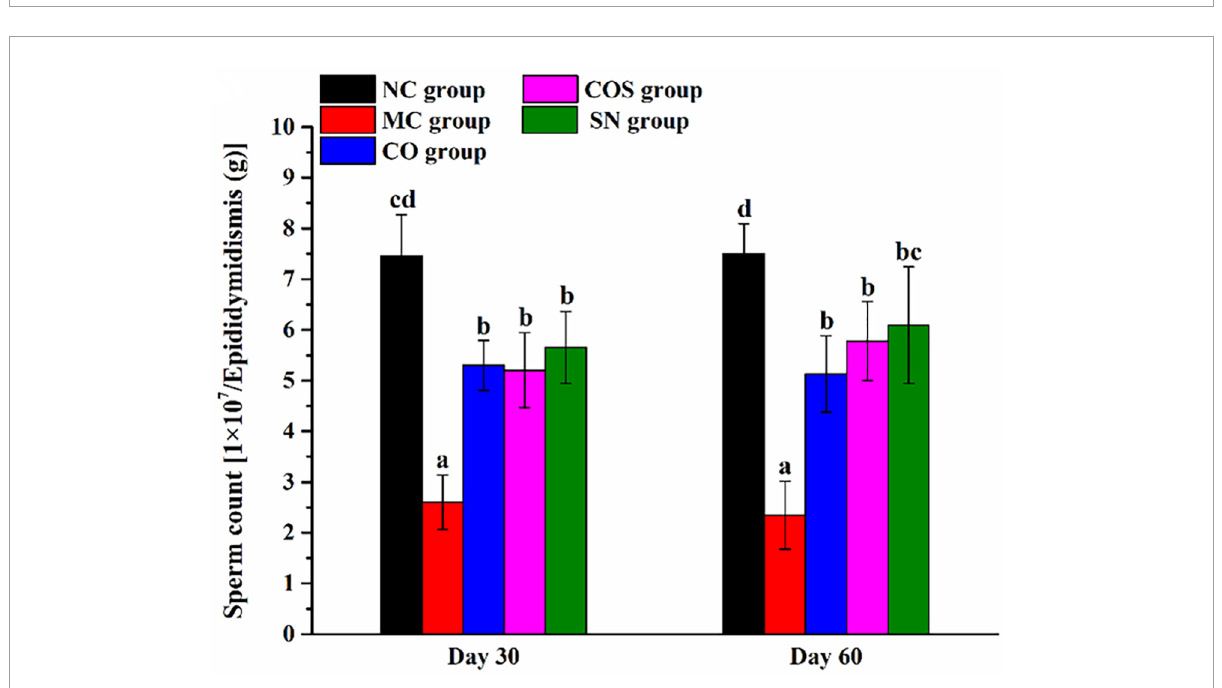
FIGURE4 Sperm counts in the epididymidis of hyperlipidemia-induced reproductive damage rats. NC, normal control; MC, model control; CO, Camellia oil; COS, Camellia oil + squalene; SN, sildenafil. All values are expressed as mean ± SD. Different letters represent significant differences ( p <